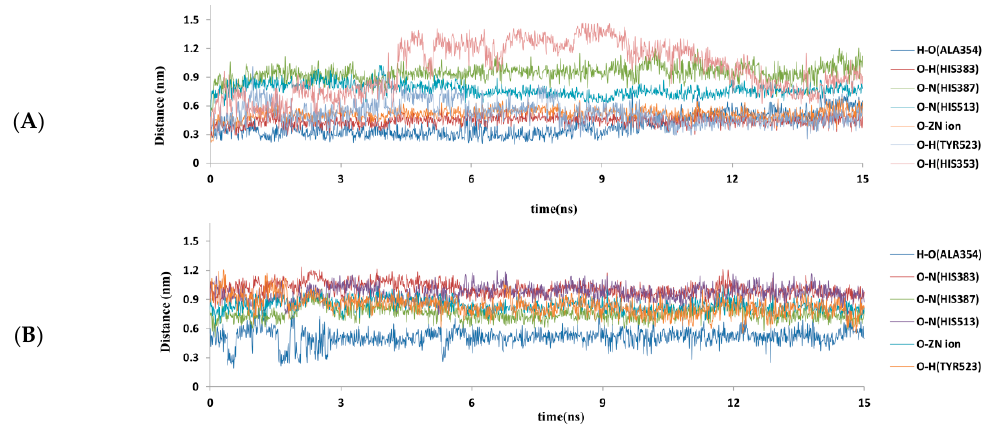
Figure 9. Time dependent atom distances (nm) for: lisinopril ( A ); and NPATY ( B ) in the 1O86 binding site during 15 ns MD simulation.